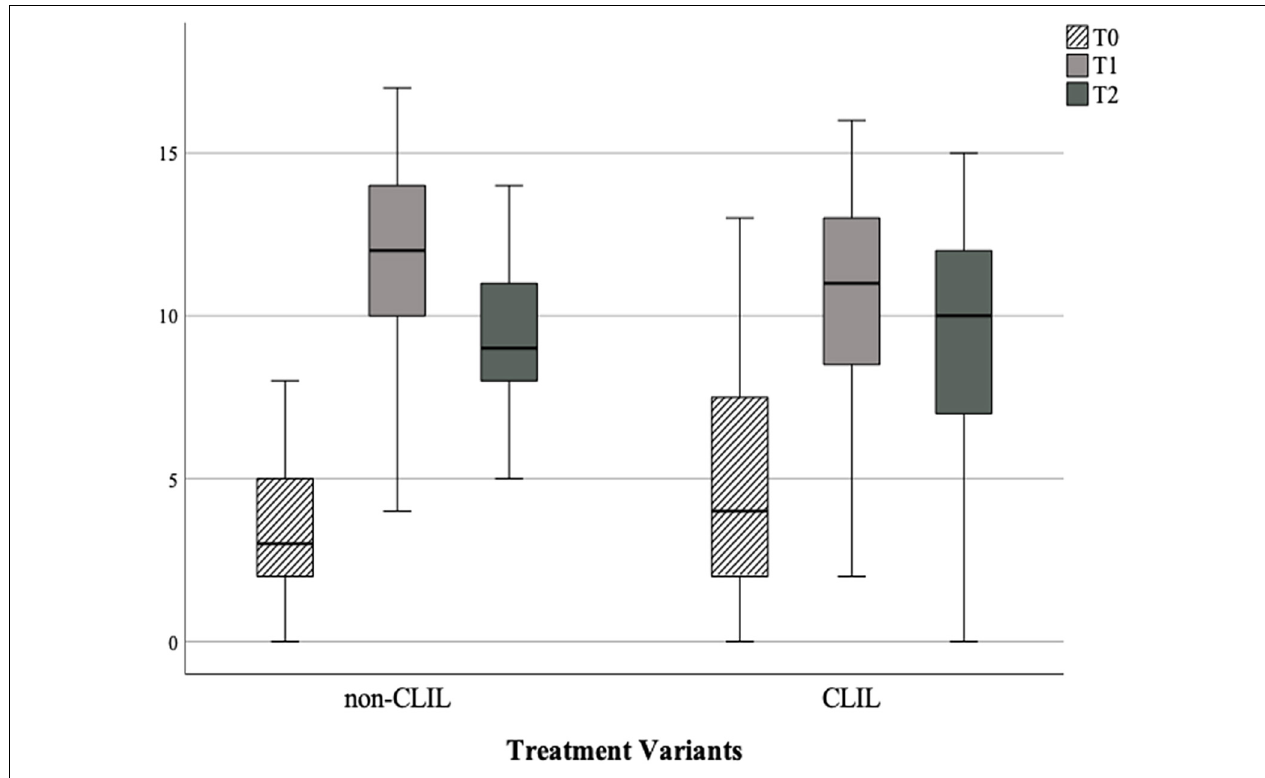
FIGURE 2 | Differences between non-CLIL and CLIL learners for knowledge of “DNA as a model” at the three different testing times.